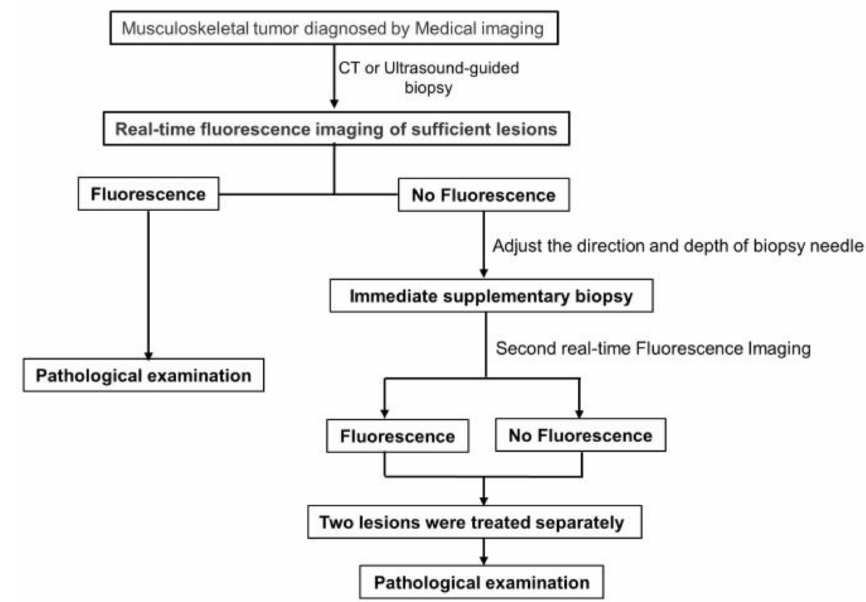
Figure 1. Research and design technology roadmap of the test